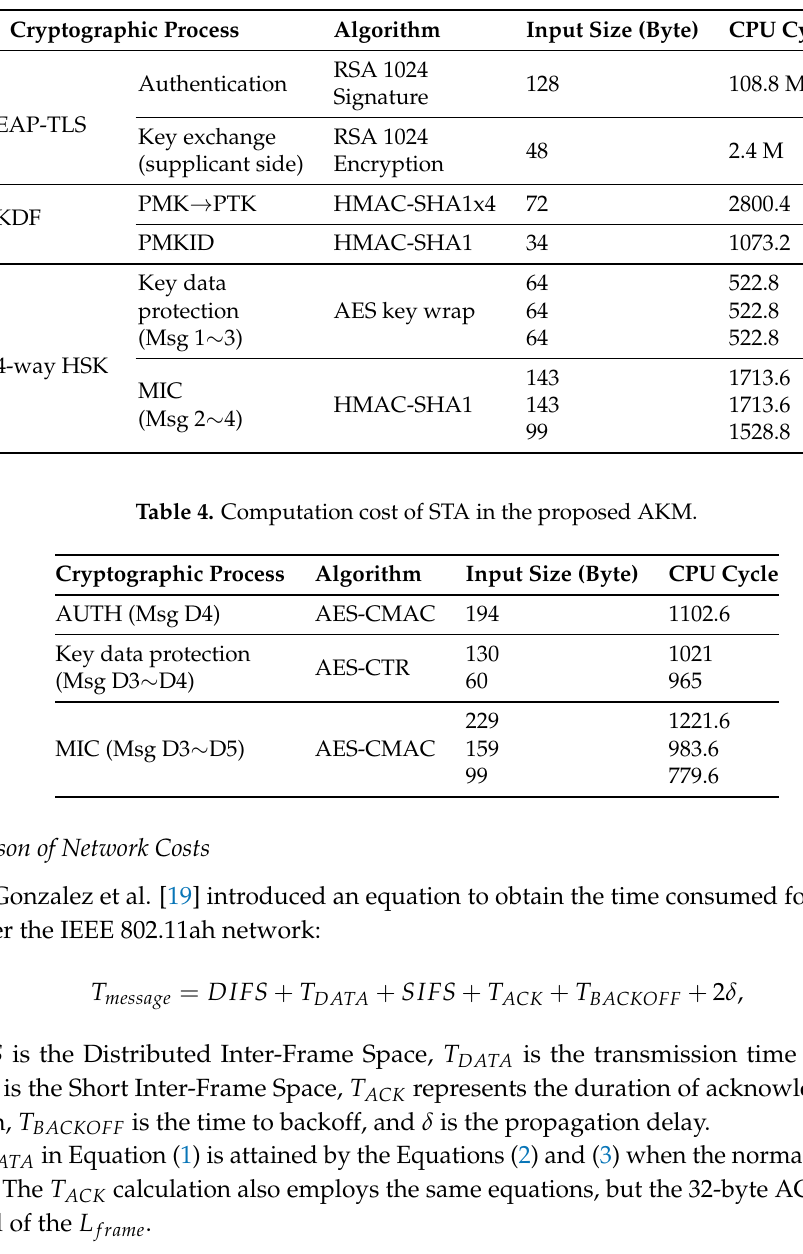
Table 3. Computation cost of STA in IEEE 802.11 with IEEE 802.1X AKM.